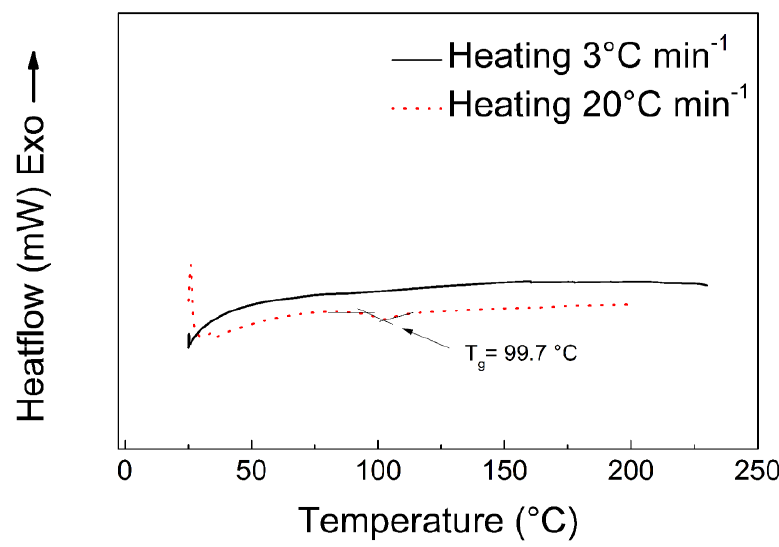
Figure 14. DSC spectra for neat coPA.